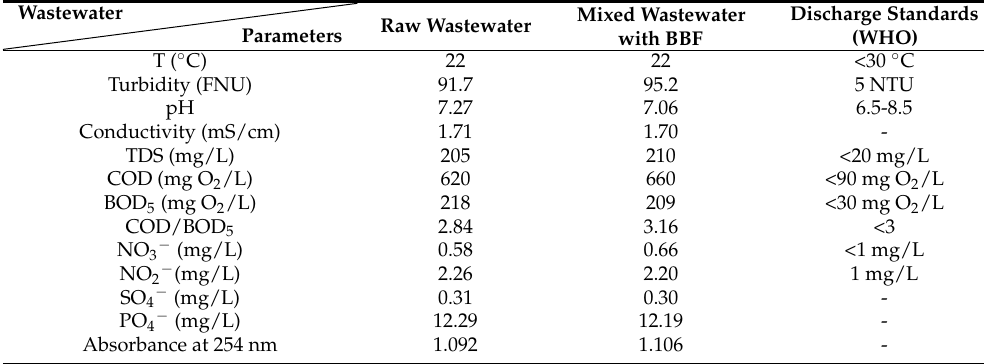
Table 1. Characteristics of industrial wastewater sampled in November 2020 and used for nanofiltra- tion